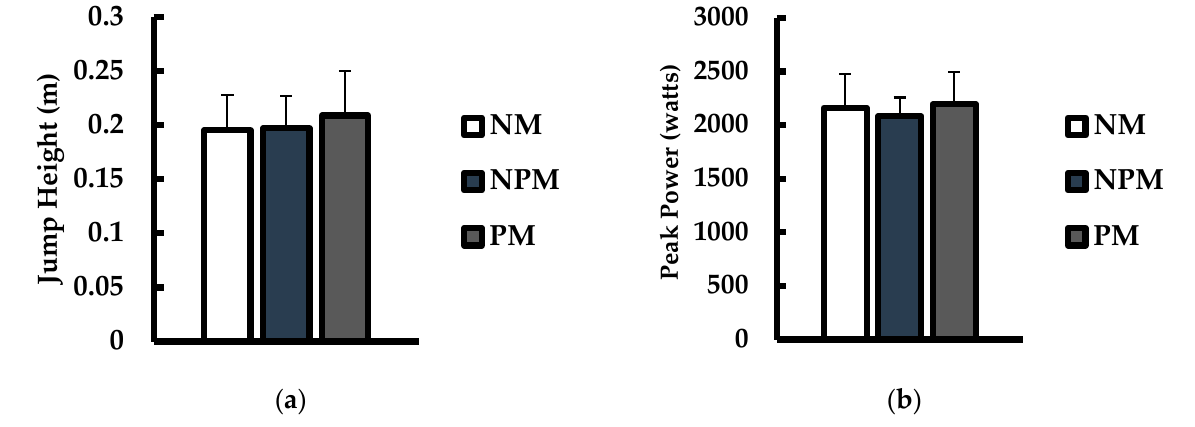
Figure 1. Comparisons of ( a ) peak force (N) and ( b ) rate of force development (at 200 ms; N·s − 1 ) during maximal isometric mid-thigh pull tests between no music (NM; white), non-preferred music (NPM; blue), and preferred music (PM; grey) conditions Data are presented as mean ± SD. * indicates significantly different than NPM ( p < 0.05).